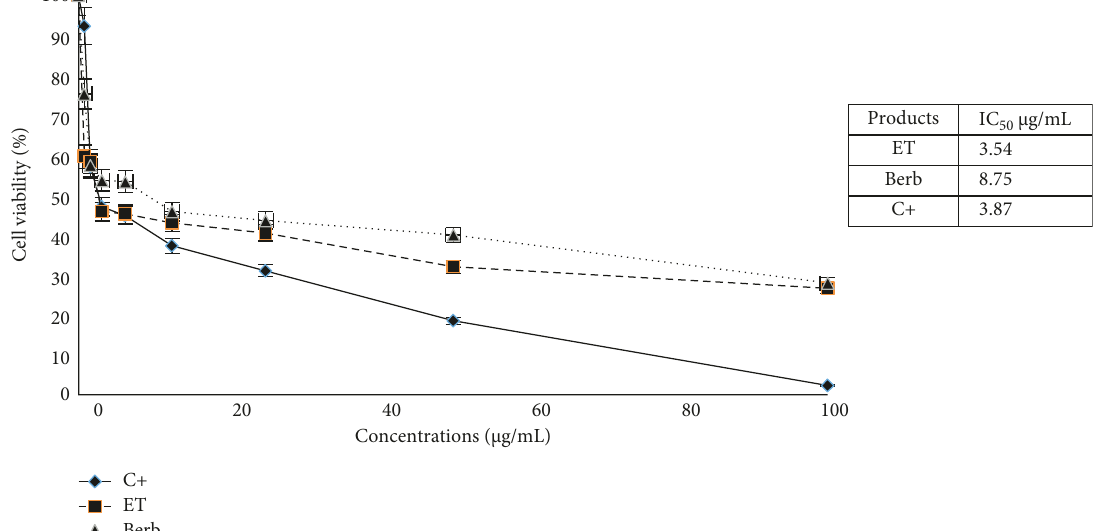
Figure 4: Cytotoxic effect of berberine against the MCF-7 cell line. ET: ethanol extract, Berb: berberine, C+: positive control